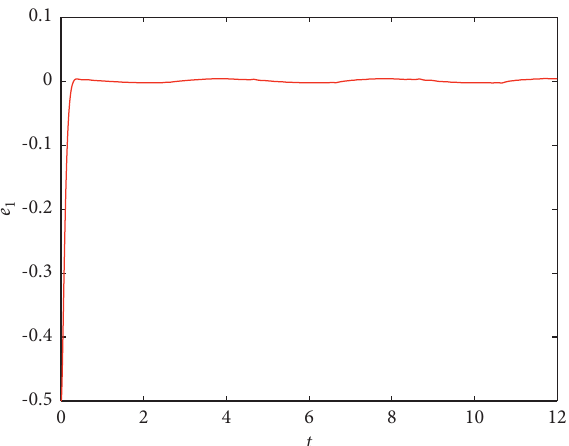
Figure 3: State error e